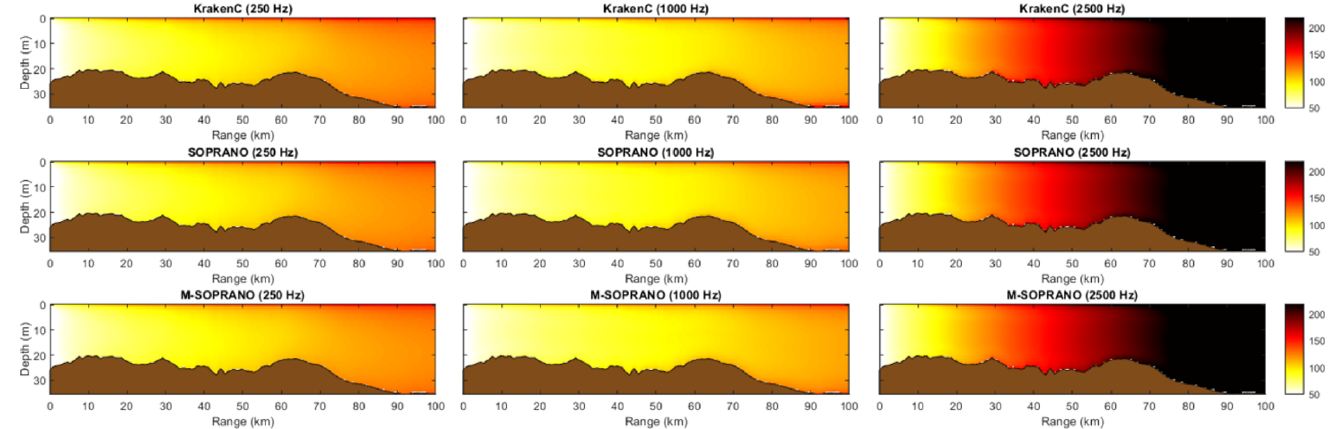
Figure 7. Comparisons for the propagation loss (dB re 1 m 2 ) at 250 Hz, 1 kHz and 2.5 kHz with KRAKENC ( upper ), SOPRANO ( middle ) and M-SOPRANO ( lower